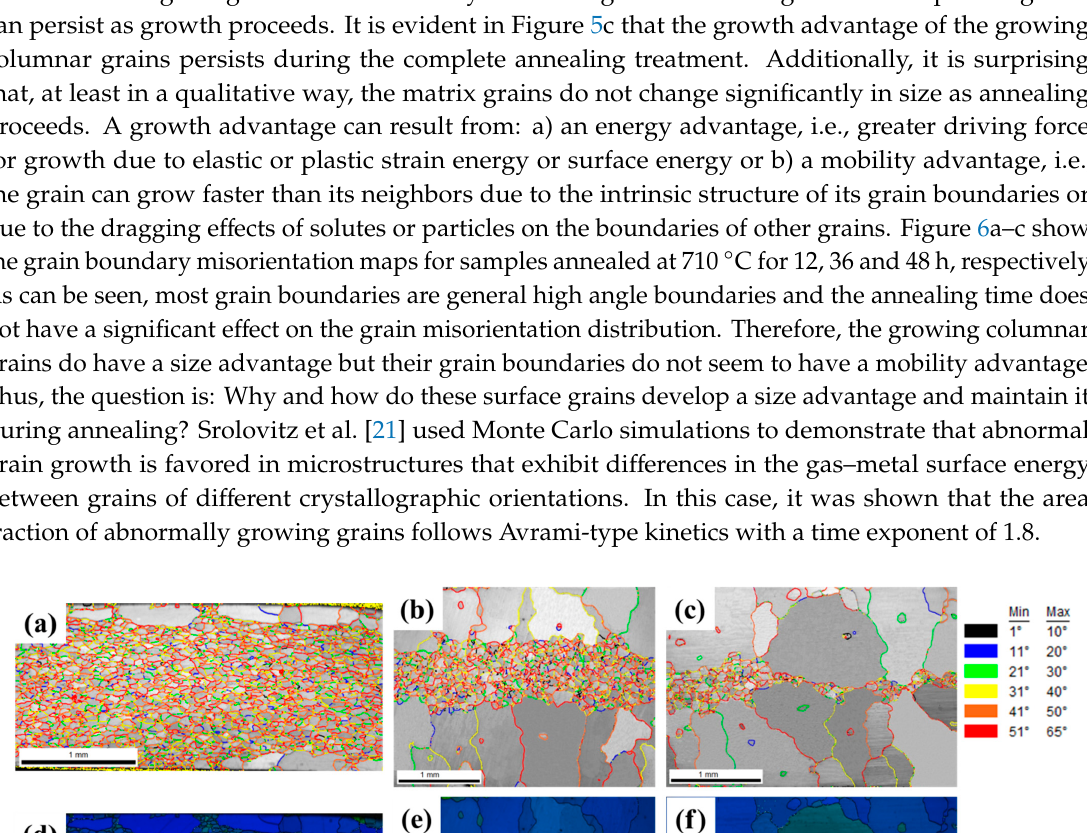
Figure 7. Kinetics of abnormal grain growth at 710 and 740 °C during isothermal annealing.